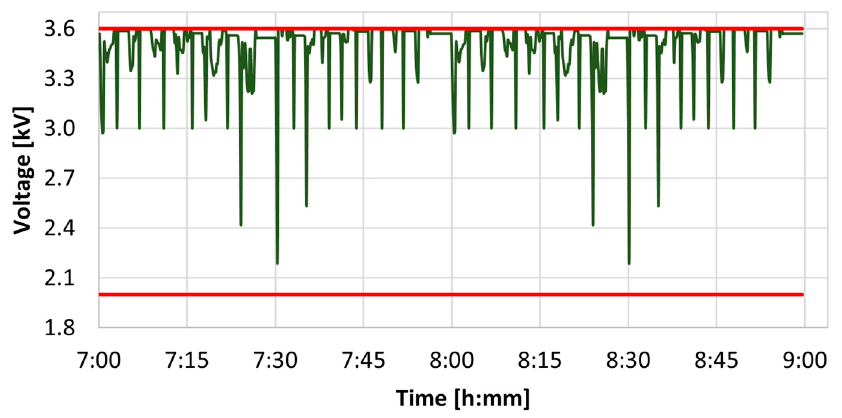
Figure 15. Minimum line voltage.